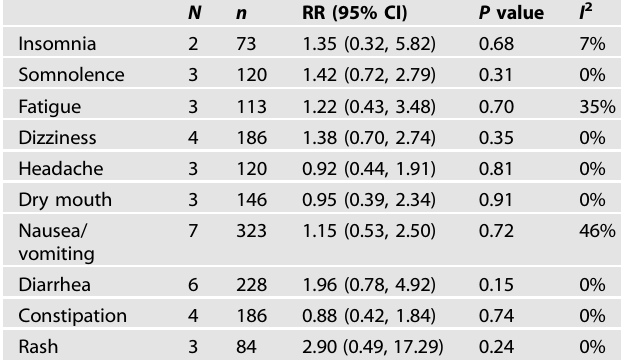
Table 4. Safety outcomes: N-acetylcysteine versus